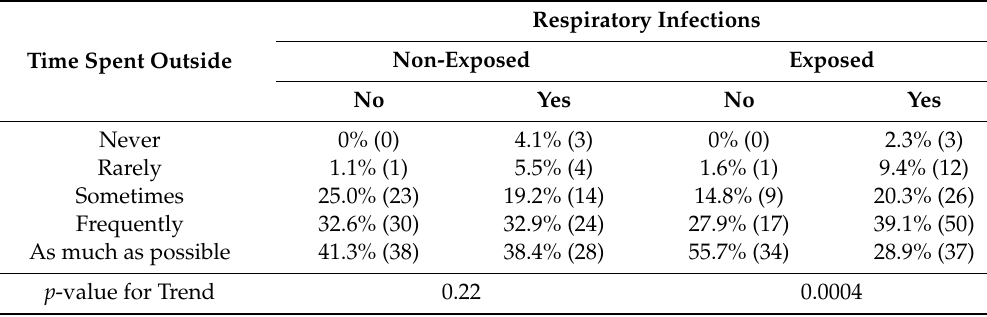
Table 4. Gradient response of respiratory infections by time spent